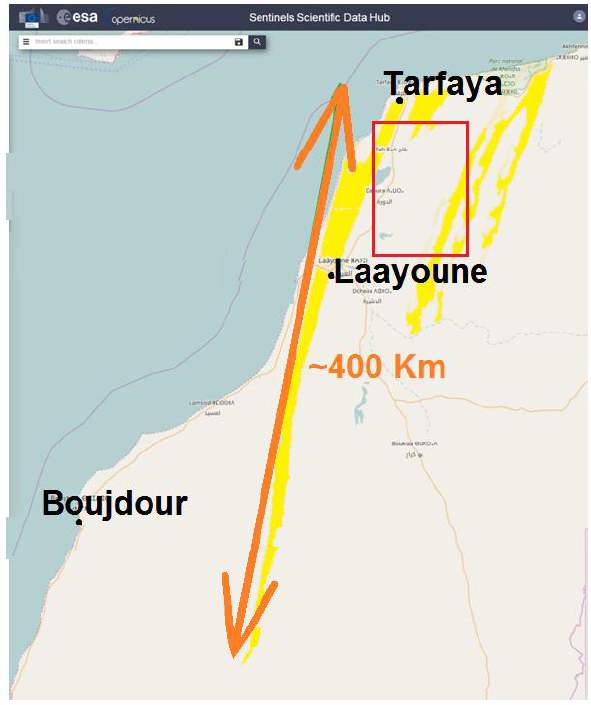
Figure 1: The study area location. Yellow: Barchans corridor. Red box: Area of interest Our goal is the segmentation of barchans dunes